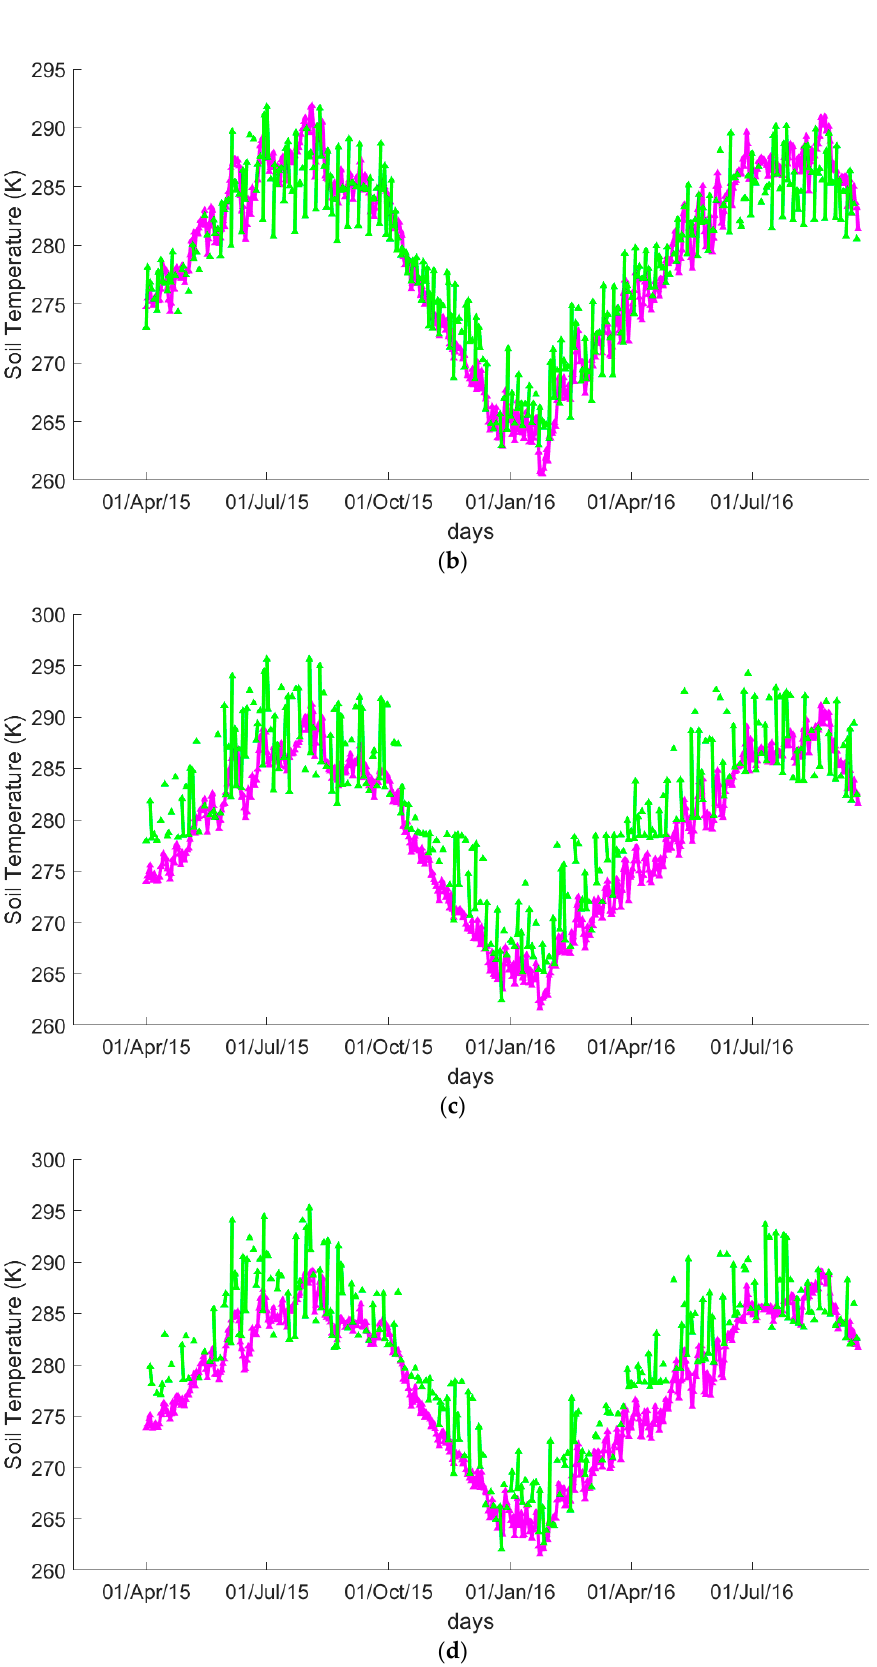
Figure 4. Temporal evaluation of station-averaged surface temperature (purple) and SPL3SMP_36km surface temperature (green): ( a ) Grid_2139, ( b ) Grid_2140, ( c ) Grid_2141, and ( d )